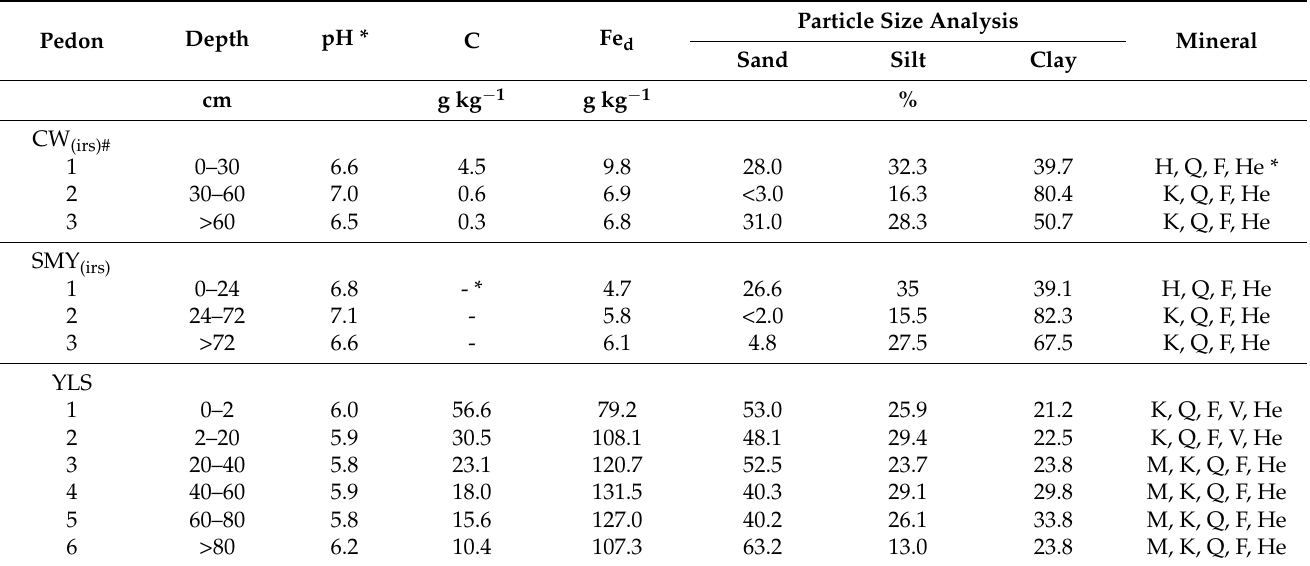
*-: not detected; F: feldspar; H: halloysite; He: hematite; K: kaolinite; M: mica; Q: quartz; V: